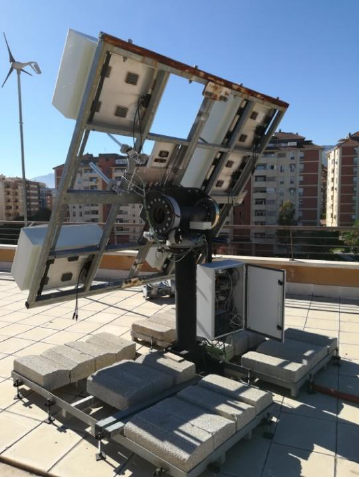
Figure 8. The designed high-concentration photovoltaic system (HCPV)